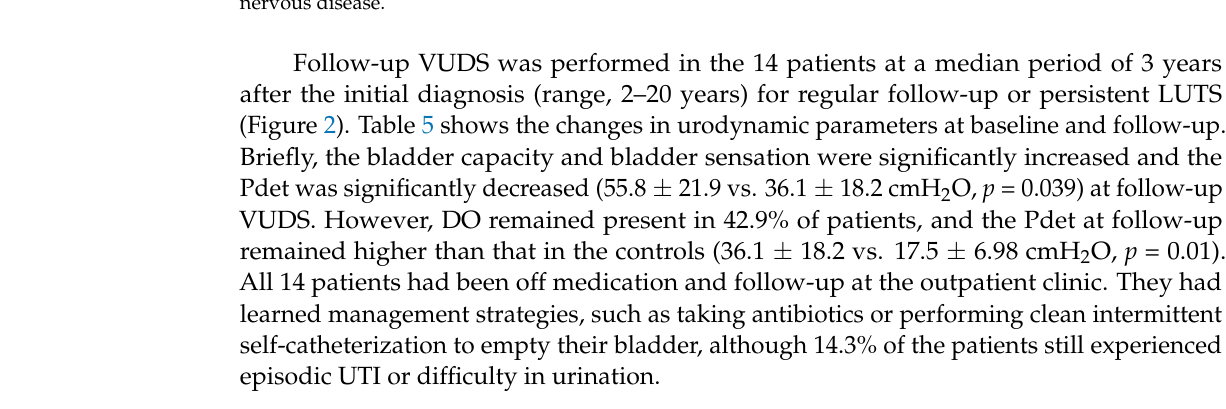
Table 5. Urodynamic parameters at baseline and long-term